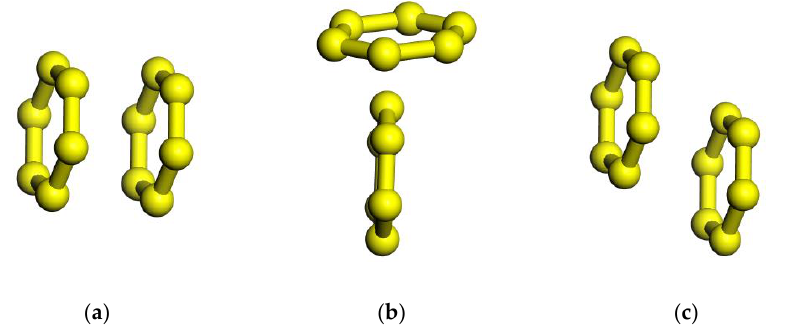
Figure 4. Three kinds of different stacking methods of aromatic rings. ( a ) Face – face stacking, ( b ) edge-on or T-shaped stacking, and ( c ) offset stacking.